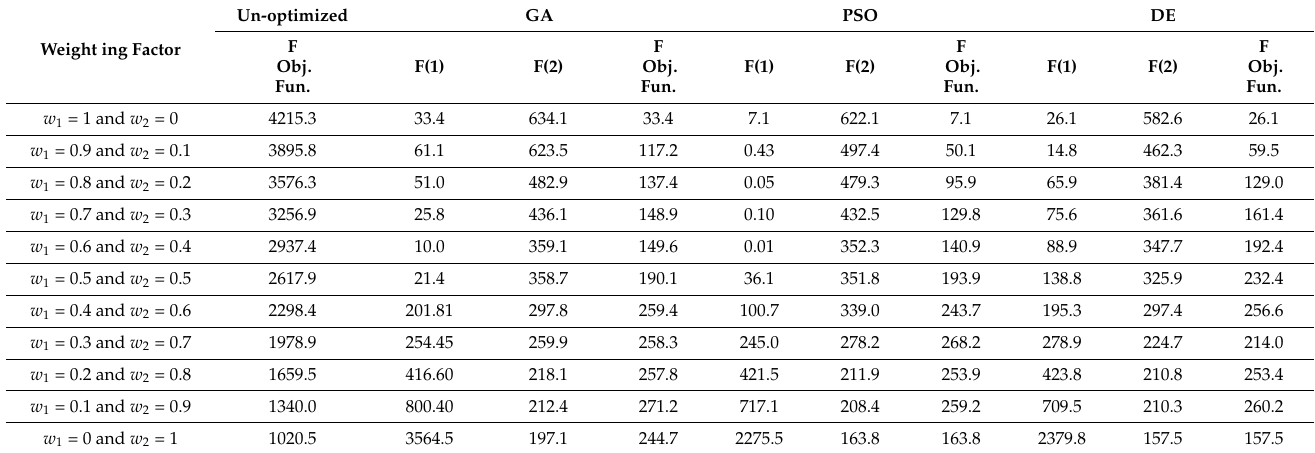
Table 2. The total objective function for different weighting factors for three methods.